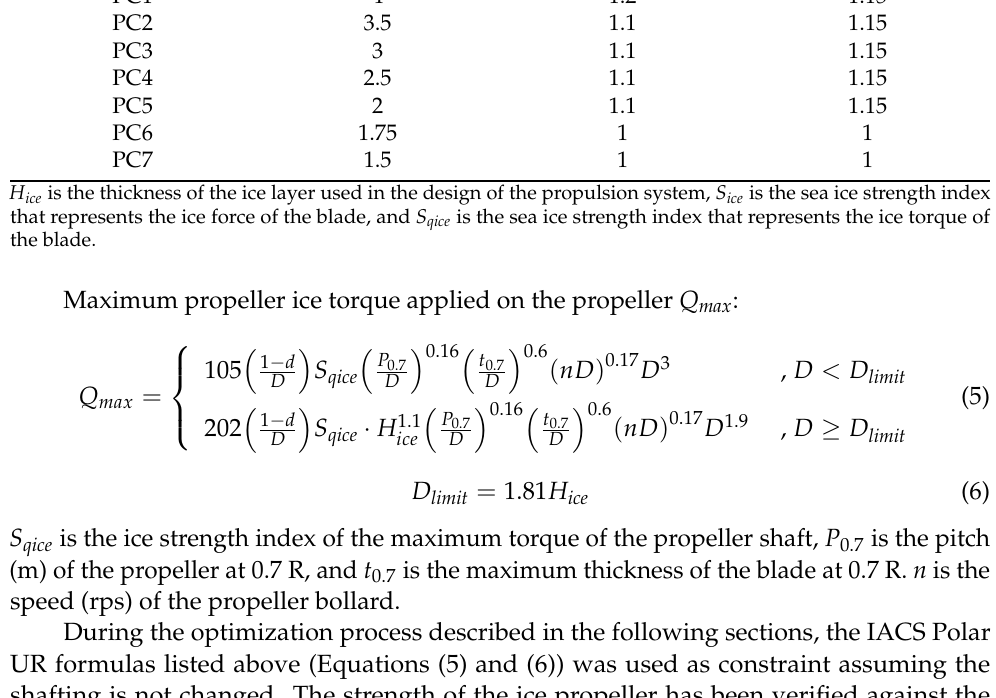
Table 1. Ice class coefficient table. Ice